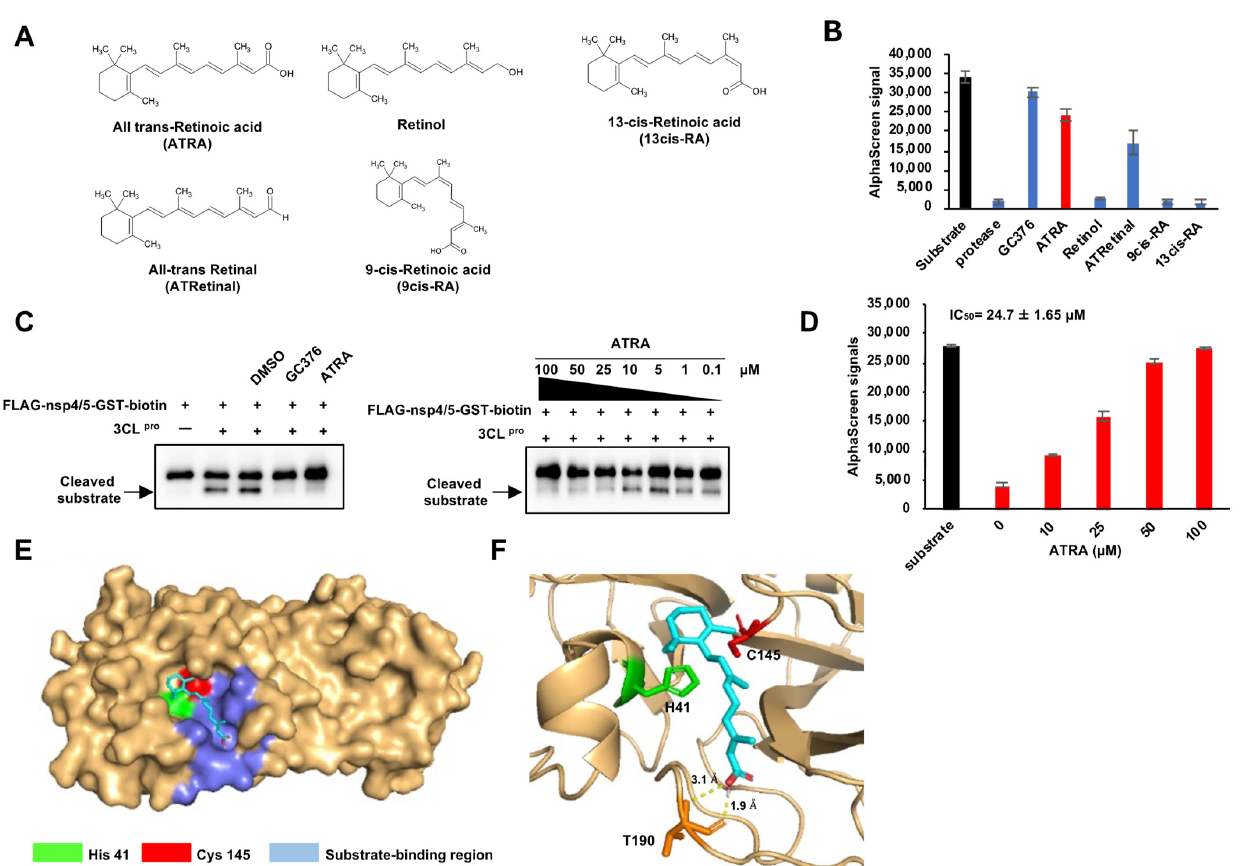
Figure 2. ATRA as a potent SARS-CoV-2 3CLpro inhibitor ( A ) The structure of retinoids used in this study. ( B ) The results of enzyme assay for different retinoids (ATRA; colored red). Error bars obtained from duplicate testing. ( C ) In vitro cleavage assay, the recombinant substrate was cleaved by SARS-CoV-2 3CLpro, which was confirmed by immunoblot. A cleaved substrate formed a band right below the substrate band. Substrate cleavage by SARS-CoV-2 3CLpro was inhibited by GC376 (100 µM) and ATRA (0.1–100 µM). ( D ) Results of the enzyme assay for ATRA in a concentration gradient (0–100 µM, colored red). Error bars obtained from duplicate testing. ( E , F ) Docked poses of ATRA and SARS-CoV-2 3CLpro showed as surface ( E ) and ribbon ( F ). The catalytic residues are His 41 (colored green) and Cys 145 (colored red). The substrate-binding region is 163–167 and 178–192 (colored blue).